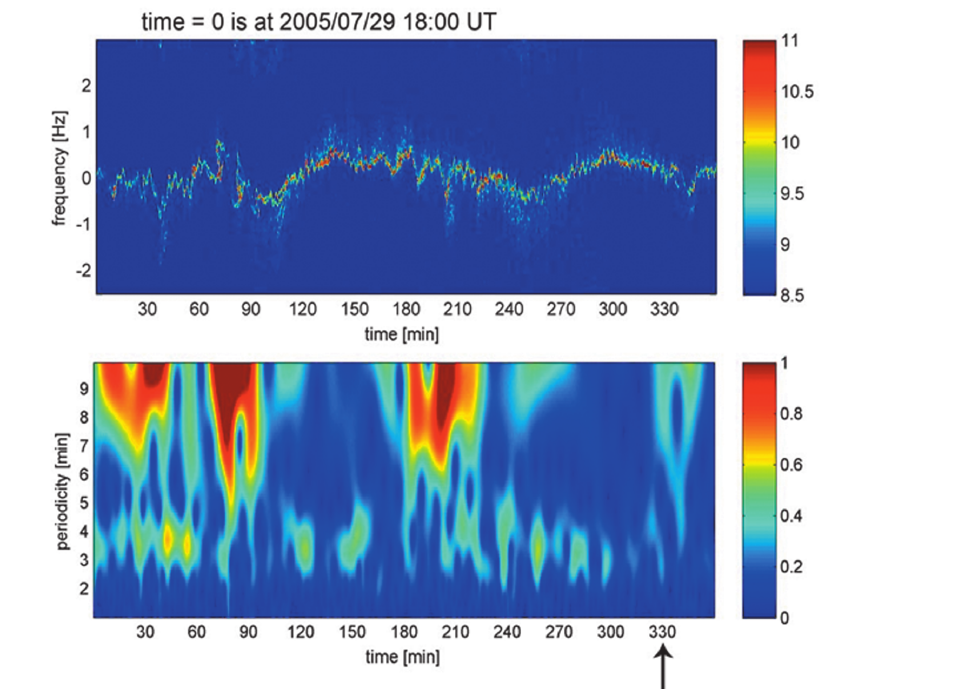
Fig. 6. Upper panel: Doppler shift spectrogram at the Panska Ves sounding path during convective storm activ- ity on 29 July 2005, start time at 18:00 UT. Lower panel: Wavelet transformation of the signal, which shows clear activity at periods 3-4 min, not related to activity at longer periods (short-period gravity waves). Arrow de- notes the approximate time of passage of the squall line of the storm under the ionospheric observation